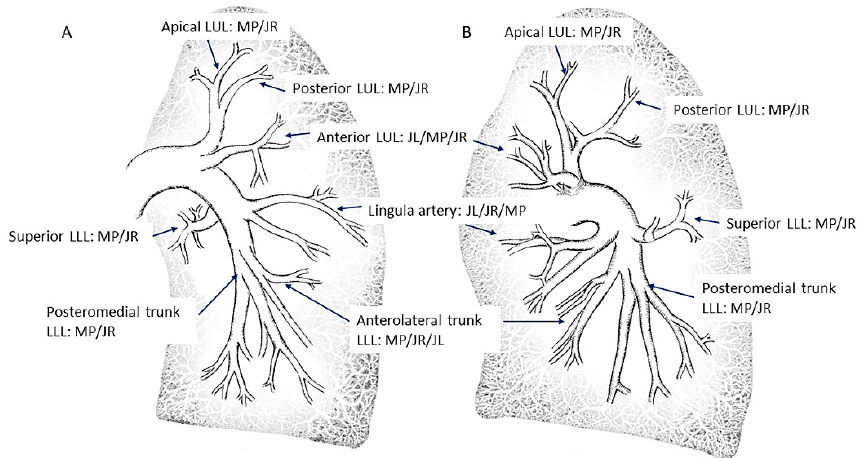
Figure 2. Left lung segmental arteries and catheters to canalize them: ( A ) anteroposterior view and ( B ) lateral view. LUL: left upper lobe; LLL: left lower lobe. Abbreviations as in Figure 1.